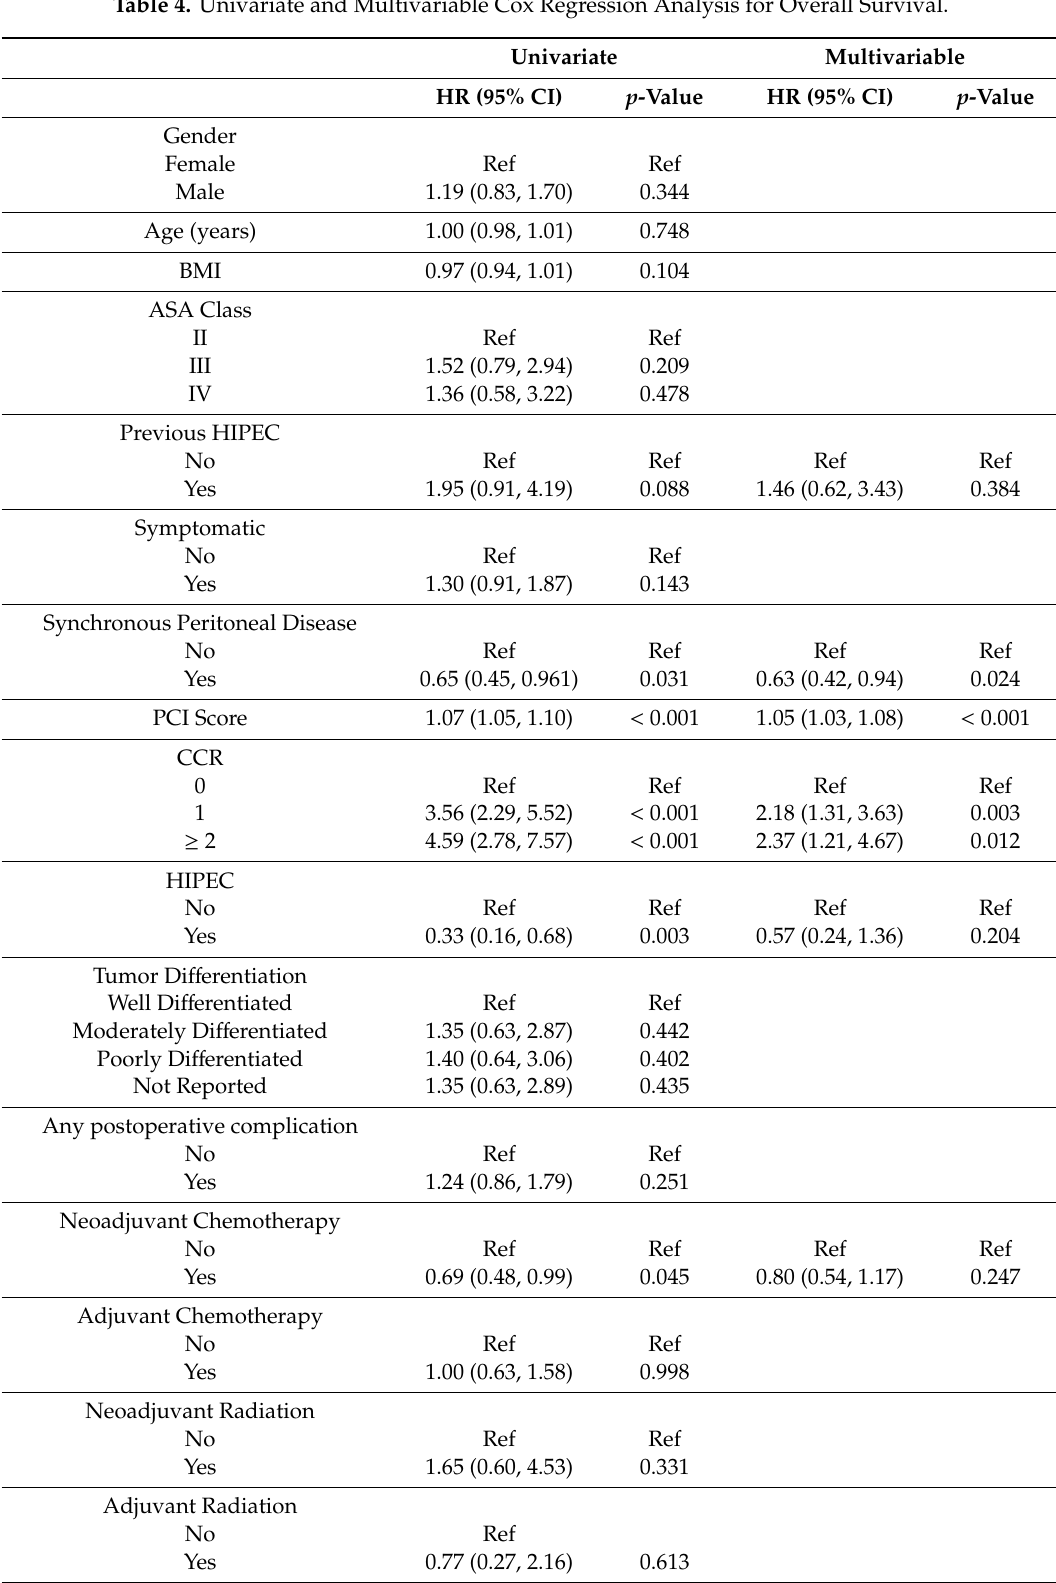
Table 4. Univariate and Multivariable Cox Regression Analysis for Overall